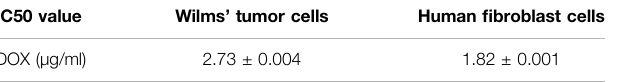
TABLE 2 | IC50 values for Wilms ’ tumor and human fi broblast cells, treated with different DOX concentrations. IC50 value Wilms ’ tumor